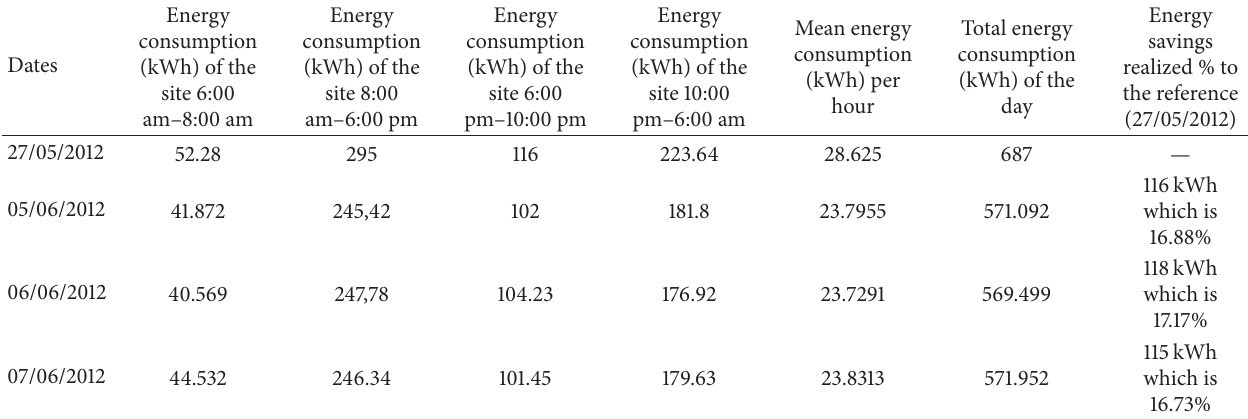
Table 7: Recapitulative of energy consumption of the 27/05/2012 and of from the 5th to 7th June 2012.